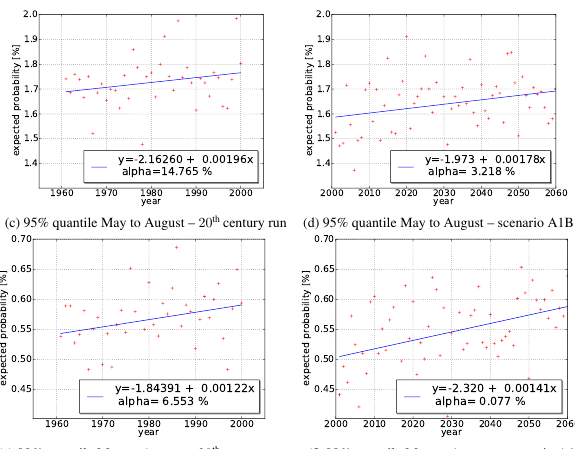
Fig.13. Lineartrendintheexpectedyearlyprecipitationsumandtheyearlyprobabilityofvaluesexceed- Fig. 13. Linear trend in the expected yearly precipitation sum and ingthe 95% and 99% quantileaccordingtotheCPsequencederivedfromECHAM5withouttemperature information;quantilesreferringtothecalibrationperiodfrom1991to2003 the yearly probability of values exceeding the 95% and 99% quan- tile according to the CP sequence derived from ECHAM5 without temperature information; quantiles refer to the calibration period from 1991 to